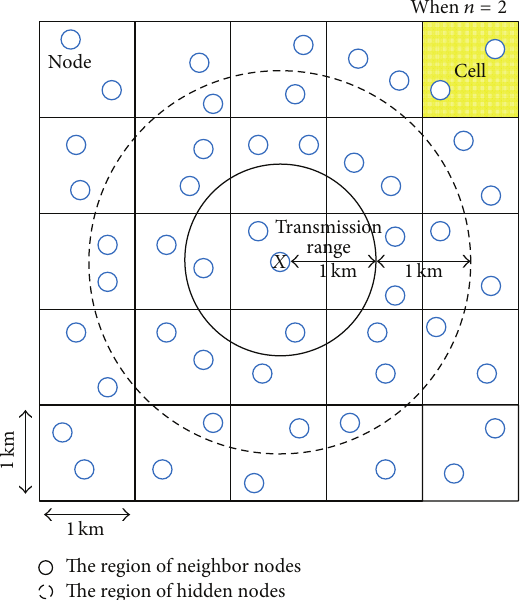
Figure 11: A simulation topology to evaluate the impact of 𝑇 ( 𝑛 = 2